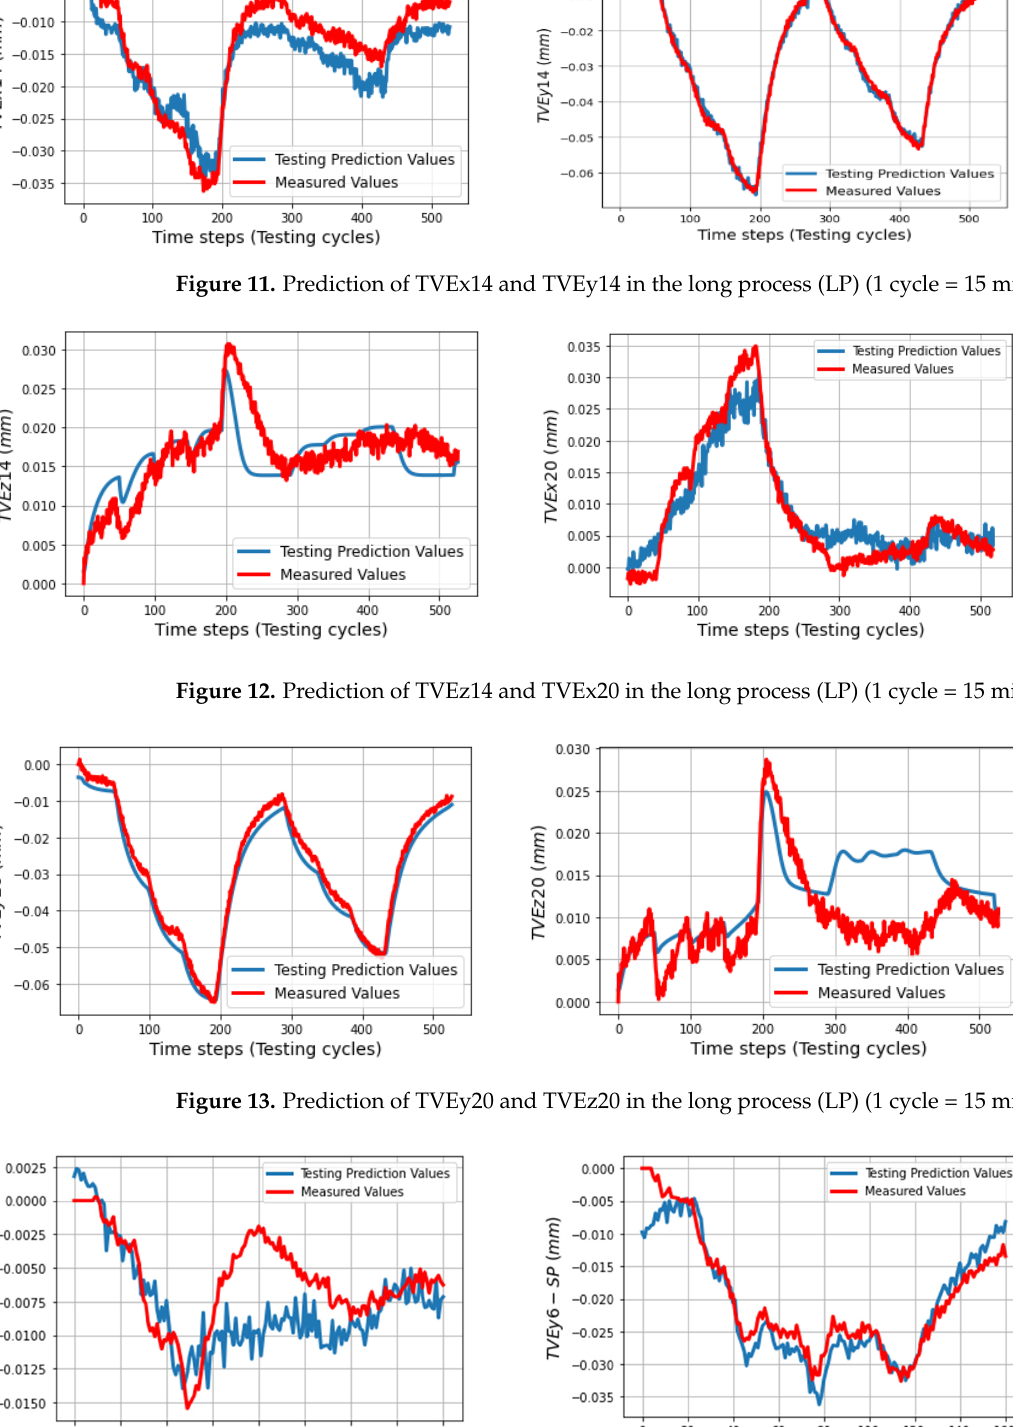
Figure 11. Prediction of TVEx14 and TVEy14 in the long process (LP) (1 cycle = 15 min) .